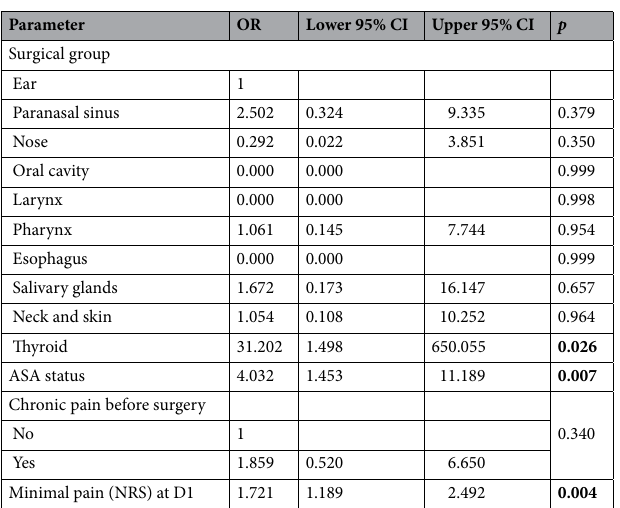
Table 3. Multivariate binary logistic regression analysis of risk factors for CPSP at 6 months (M6). NRS = numeric rating scale. Bold values are statistically significant for p < 0.05.